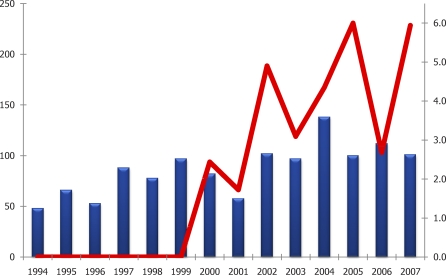
Epidemiology of ITZ Resistance in the A. fumigatus IsolatesBlue bars represent the number of patients with a positive A. fumigatus culture (left y-axis) and the red line represents the percentage of those patients with an ITZ+ isolate (right y-axis). The x-axis is the year.